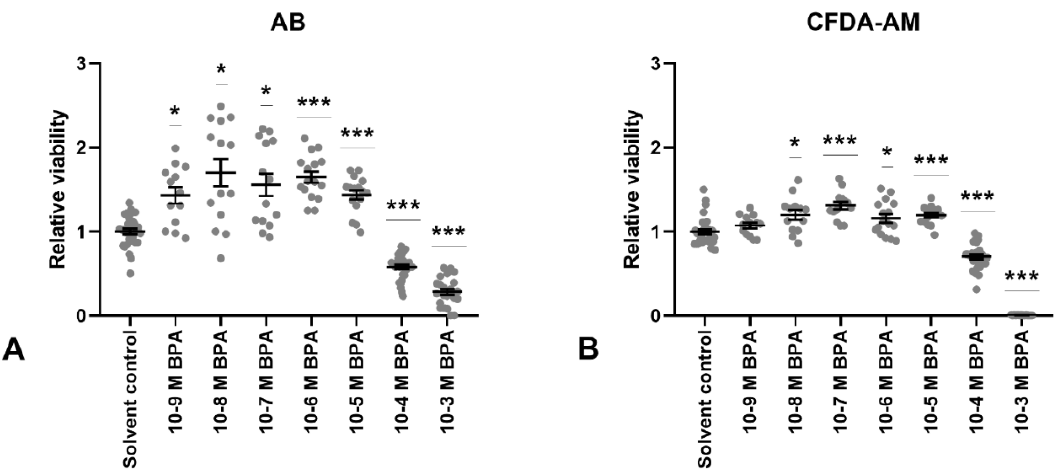
Figure 1. Viability in terms of metabolic activity (AlamarBlue (AB) assay) ( A ) and membrane integrity (5-carboxyfluorescein diacetate-actetoxymethyl ester (CFDA-AM) assay) ( B ) in Atlantic cod pituitary cells after 7 days of primary culture w / wo Bisphenol A (BPA) added to the culture media for the last 72 h. Each data point represents the sample fold change relative to mean solvent control. For each column, the group mean ± SEM is indicated ( n = 13–30). Statistical significance (* p < 0.05, *** p < 000.1) was assessed using the Kruskal–Wallis test followed by the Steel method.